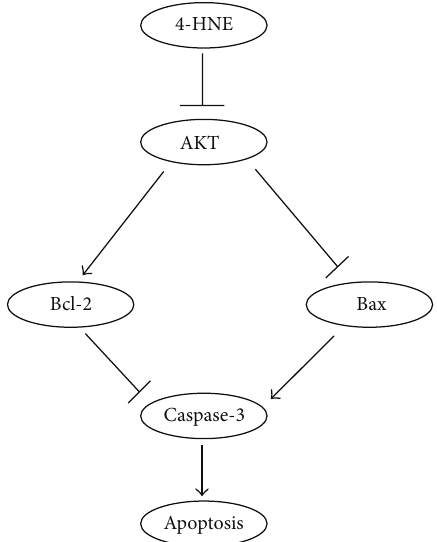
Figure 5: Models. Simplified scheme showed that 4-HNE could inactivate AKT activity, alter the ratio of BcL-2/Bax, induce caspase- 3 cascades, and finally lead to apoptosis in MG63